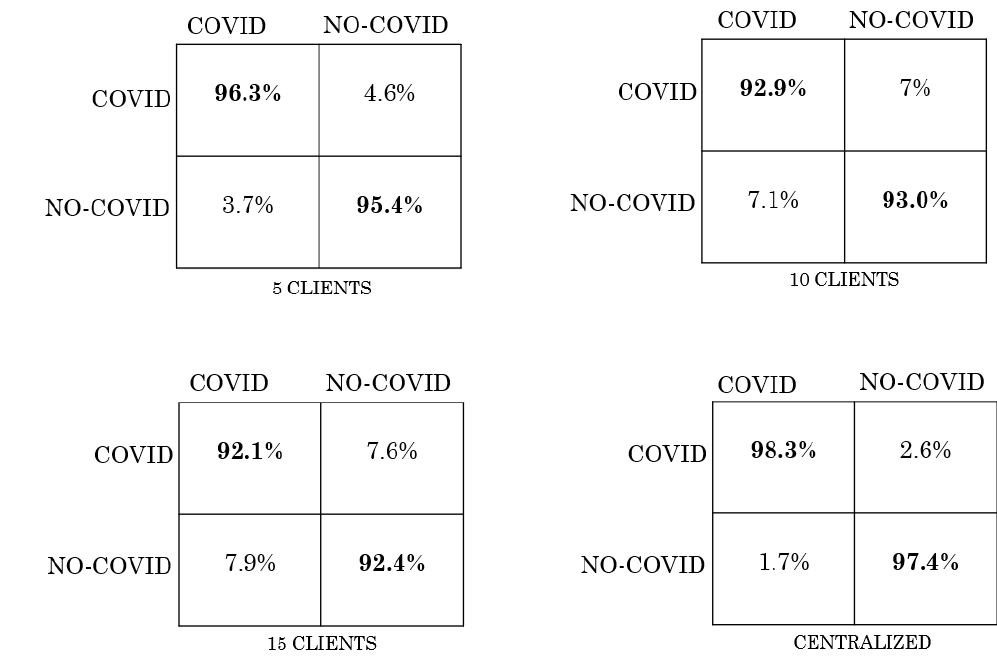
Figure 6. Confusion matrices for the IID and centralized scenarios.